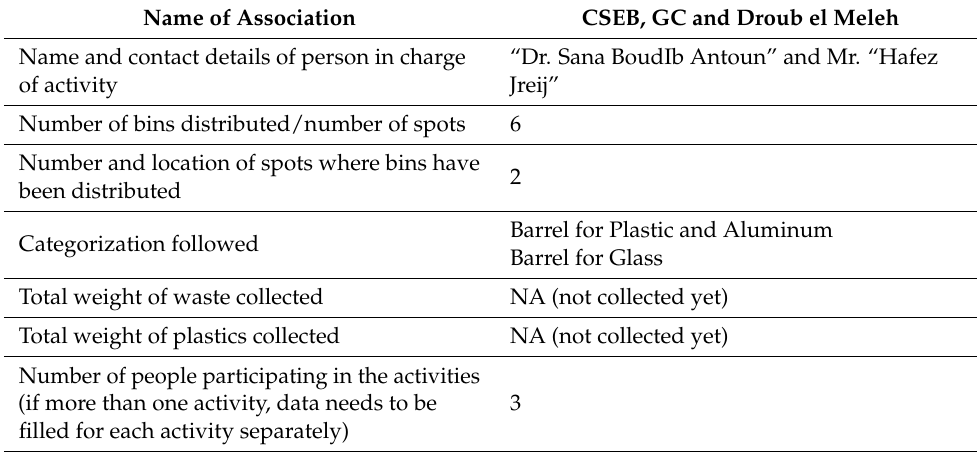
Table 3. Sorting—Recycling—Up